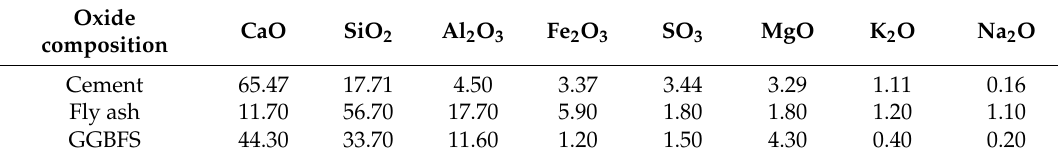
Table 2. Oxide composition of used materials